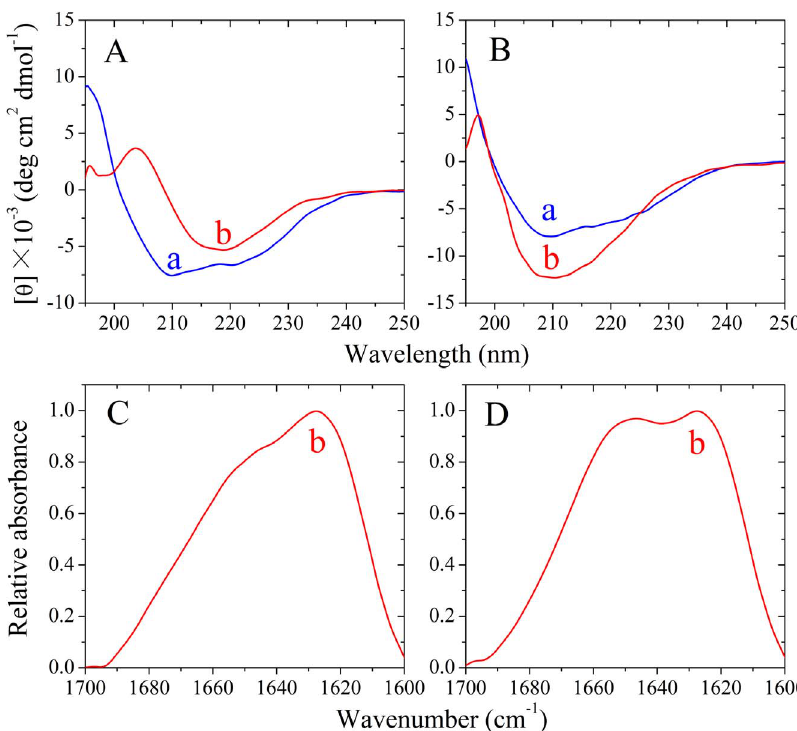
Figure 8. Secondary structural changes of chimera H (A and C) and chimera R (B and D) isoforms monitored by far-UV CD and FTIR, respectively. Curve a: native chimera prion proteins. Curve b: amyloid fibrils produced from chimera prion proteins in the absence of a crowding agent. The incubation time was chosen within a time range of the plateau of each kinetic curve of ThT fluorescence shown in Fig. S1.